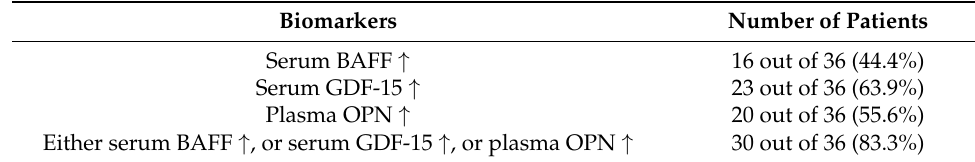
Figure 4. ( a ) The Pearson’s correlations between serum BAFF levels and serum GDF-15 levels; ( b ) The Pearson’s correlations between serum BAFF levels and plasma OPN levels; ( c ) The Pearson’s correlations between plasma OPN levels and serum GDF-15 levels. Table 1. Application of the cutoff values of three biomarkers in 36 metastatic